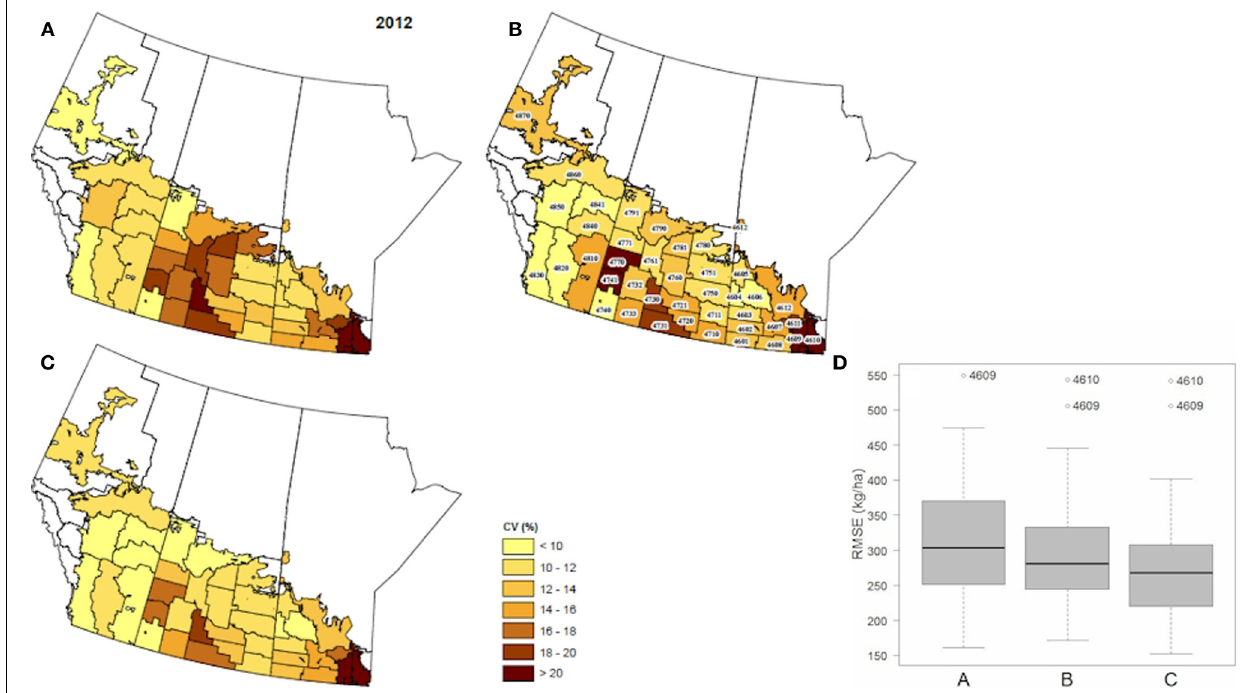
FIGURE 8 | Left: Crop yield forecast for 2012—spatial distribution of model error (CV %) for all CARs in the study region in forecasting spring wheat crop yield in 2012, with: (A) agroclimate indices (WDI,